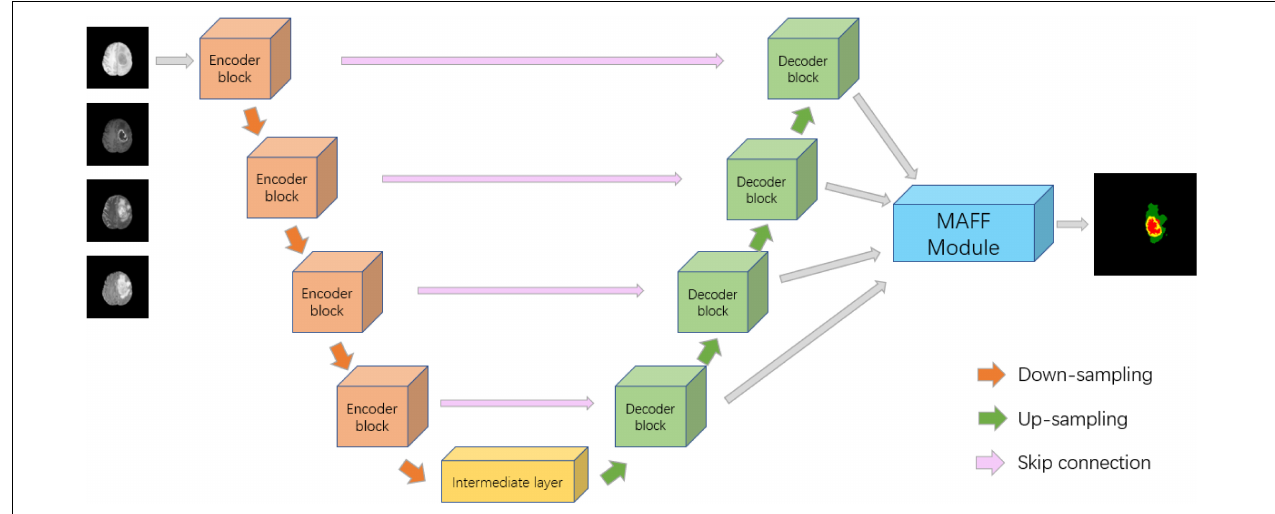
FIGURE 2 | Architecture of the proposed MAFF-ResUNet. In the ground truth image, red, green and yellow stand for tumor core (TC), whole tumor (WT), and enhance tumor (ET),